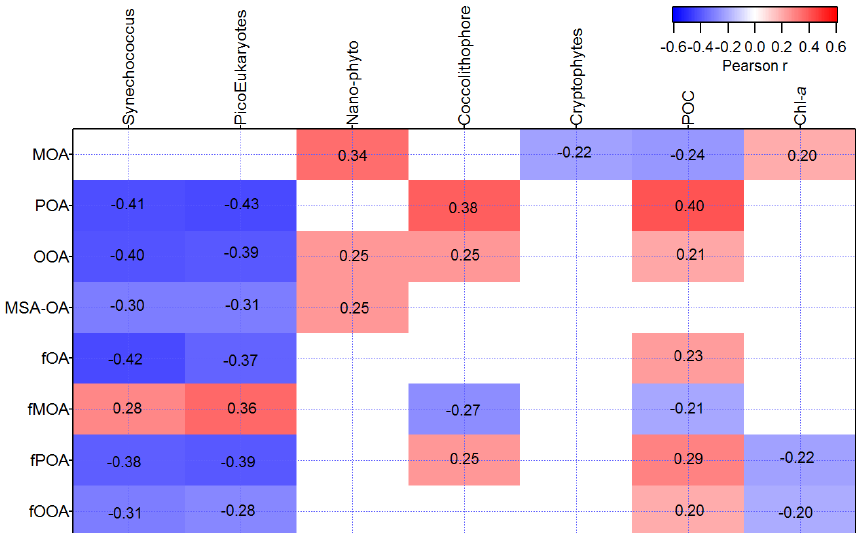
Figure 6. Pearson correlation coefficients for the four different organic factors (MOA NR , POA NR , OOA NR , and MSA-OA NR ) and their frac- tion of the total sea spray mass (fMOA, fPOA, fOOA, and fOA) with several phytoplankton functional group abundances (cells per cubic cen- timeter) ( Synechococcus , picoeukaryotes, nanoeukaryotes (Nano-phyto), coccolithophore (coccolith), cryptophytes), total chl a (mgm − 3 ), and POC (mgm − 3 ) in the sampled seawater during the whole campaign. Sample number = 461. Correlations with absolute R values < 0.16 had Pearson’s two-tailed significance values lower than 0.001 and were therefore left